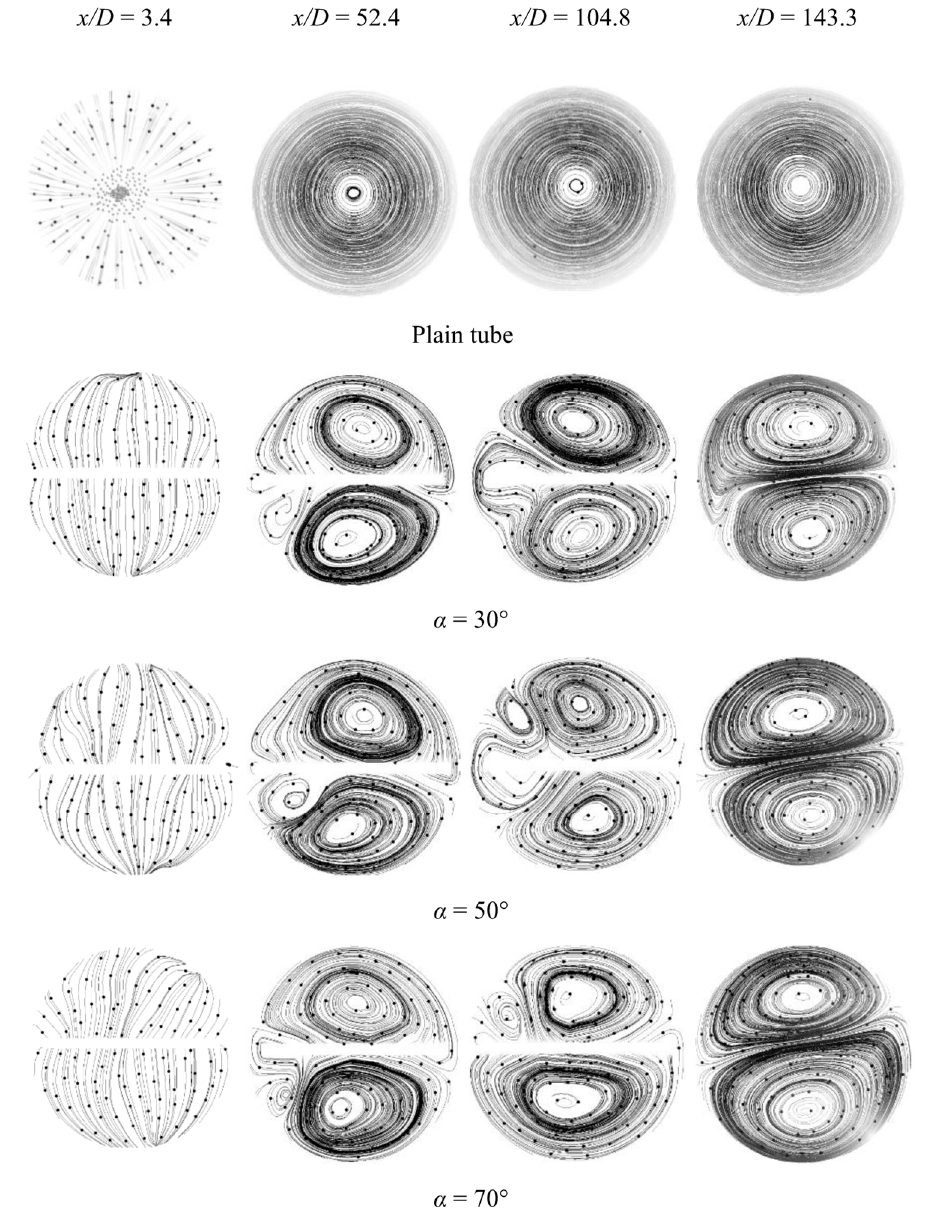
Figure 7. Streamline in cross sections at Re = 17,400.